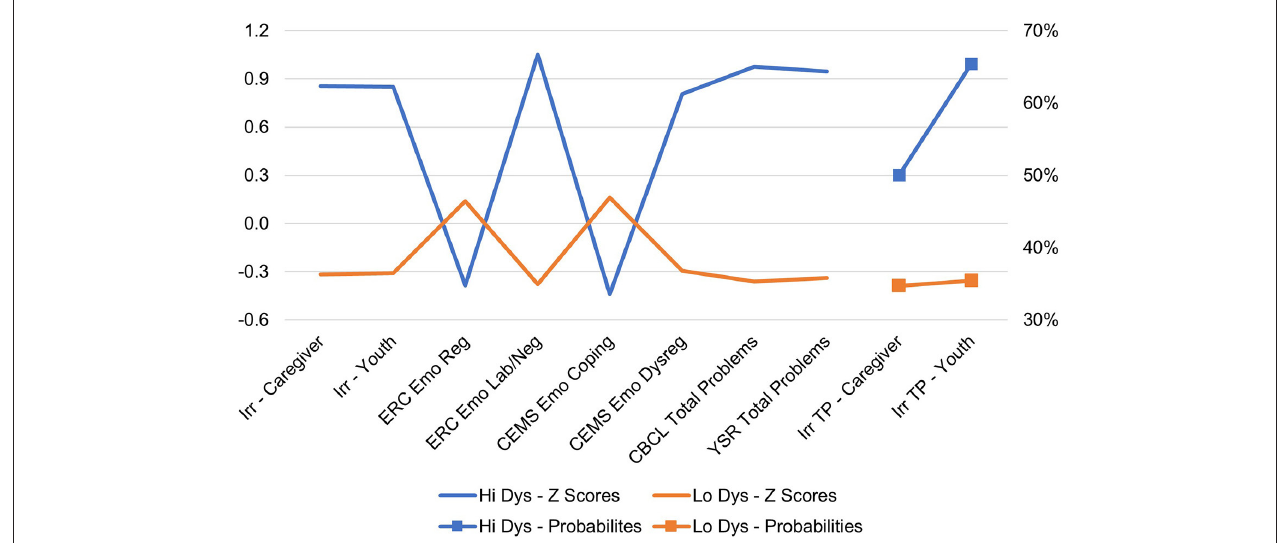
FIGURE 1 | Two latent profiles: high dysregulation ( n = 54) and low dysregulation ( n = 146). Irr, irritability; ERC, Emotion Regulation Checklist; CEMS, Children’s Emotion Management Scales; CBCL, Child Behavior Checklist; YSR, Youth Self-Report; TP, top